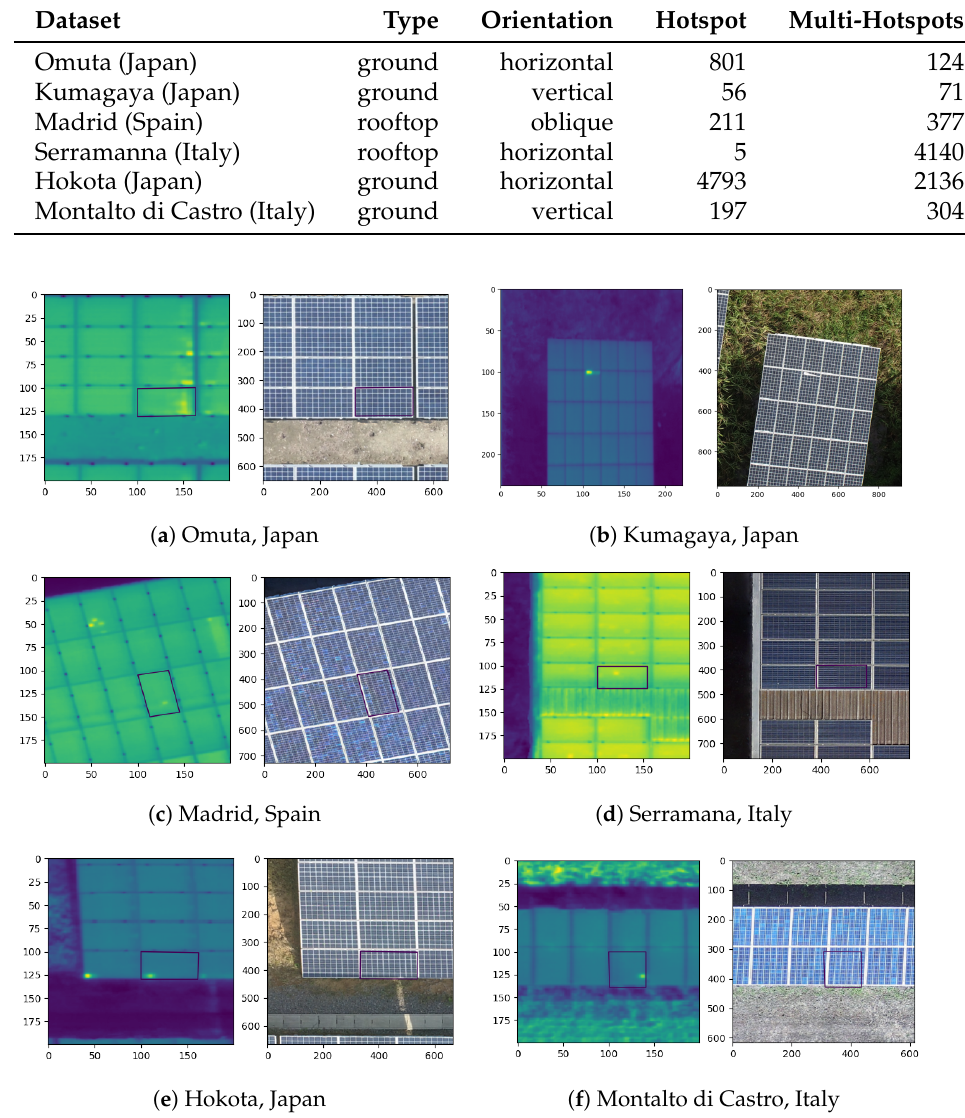
Figure 5. Images from the different datasets, captured at various PV plants in Italy, Spain and Japan. The aggregated dataset is highly diverse, containing ground-based and rooftop-based PV sites. Flights were conducted using flight lines that are parallel, perpendicular or oblique to the orientation of the photovoltaic